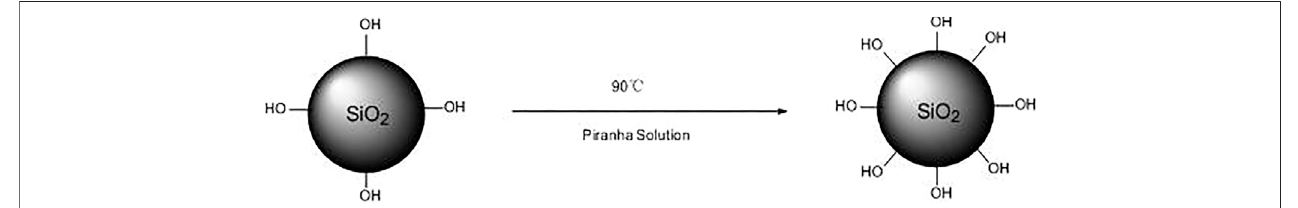
FIGURE 1 | Preparation of SA-OH